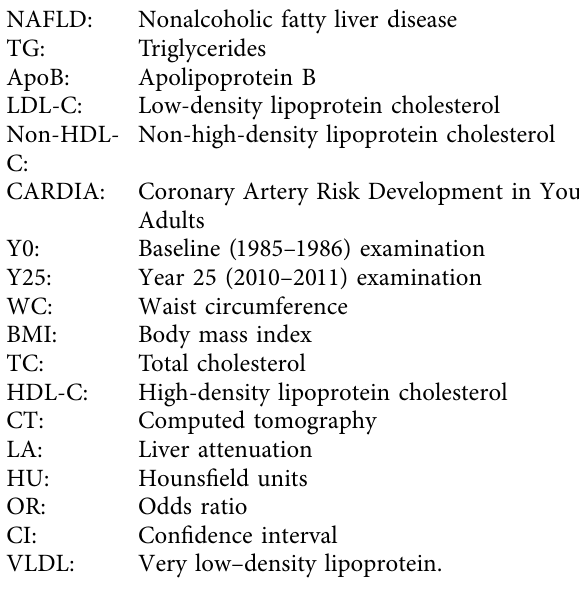
Supplemental Table 1. Baseline and Y25 Characteristics of Table 2. Y25 Cholesterol Levels in Relation to Odds of Y25 Moderate-Severe NAFLD ∗ . ( Supplementary Materials